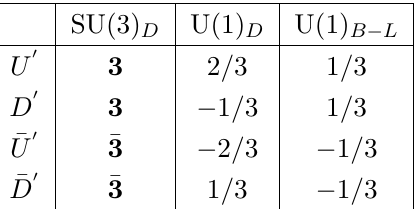
Since the dark quarks are in the vector-like representation, they have